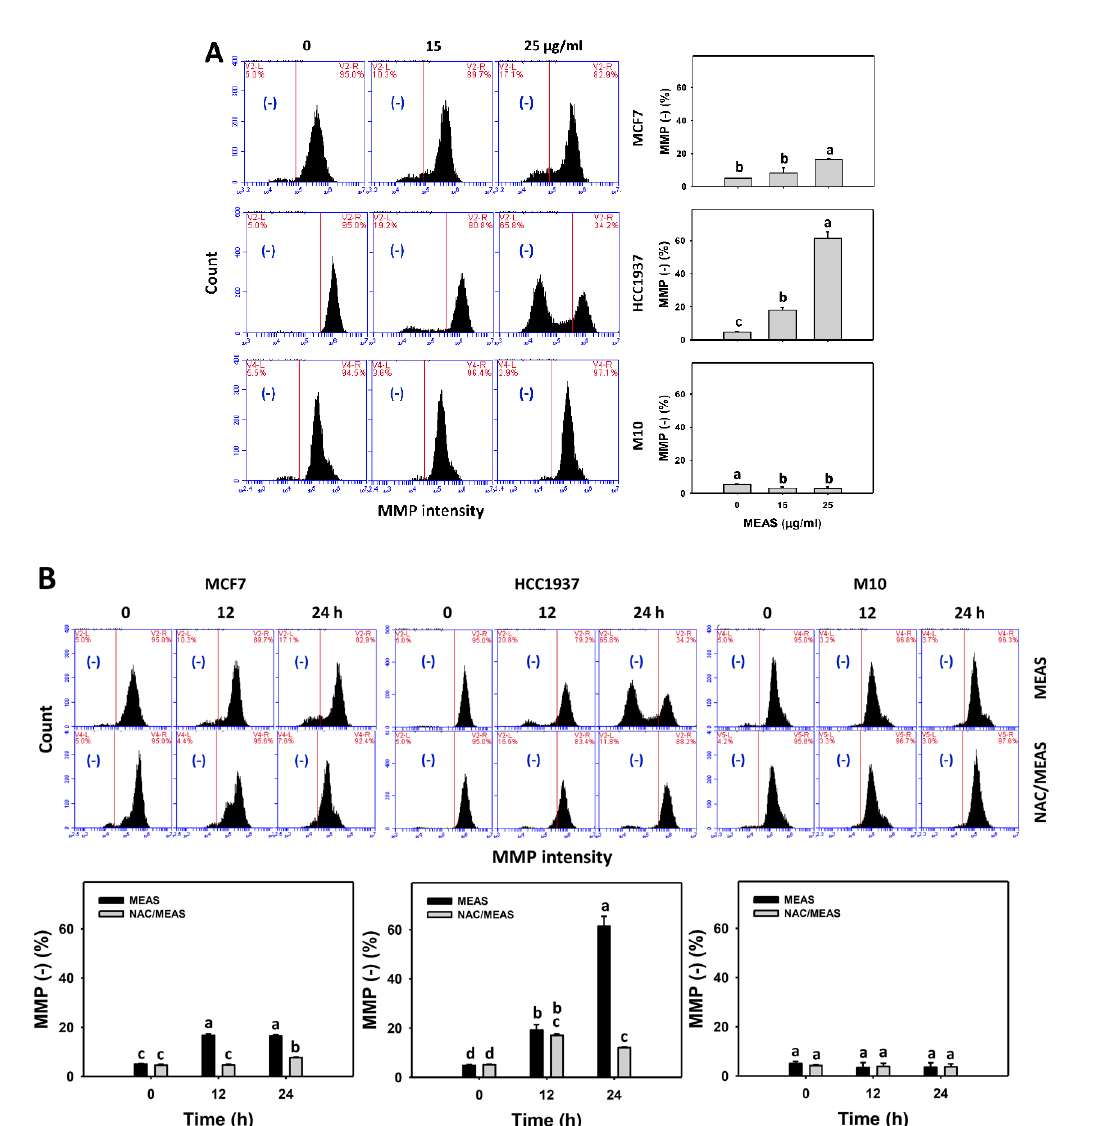
Figure 7. MEAS increased MMP (−) intensities of breast cancer cells. ( A ) MMP assay of MEAS. Except for normal breast cells (M10), others were TNBC and non-TNBC cells. Flow cytometry was performed after 24 h drug treatment. (−) , inserted within each panel, indicates the MMP (−) intensity. ( B ) MMP assay of NAC/MEAS. NAC/MEAS represents NAC pretreatment (10 mM, 1 h) and MEAS posttreatment for 0, 12, and 24 h. Data = mean ± SD ( n = 3). Statistical software assigned low-case letters to each treatment.